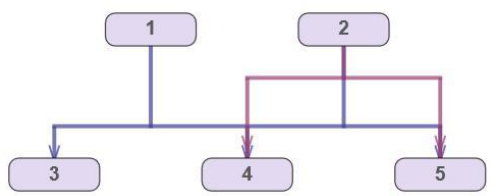
Figure 4. Optimal layout of a hypergraph; no ports allowed.